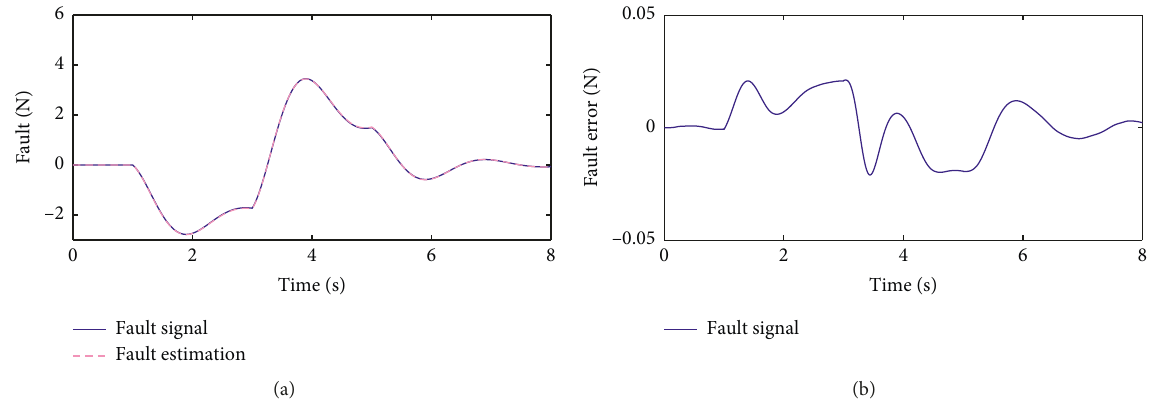
Figure 3: The variations of (a) fault estimation and (b) fault estimation error for the general fault signal.